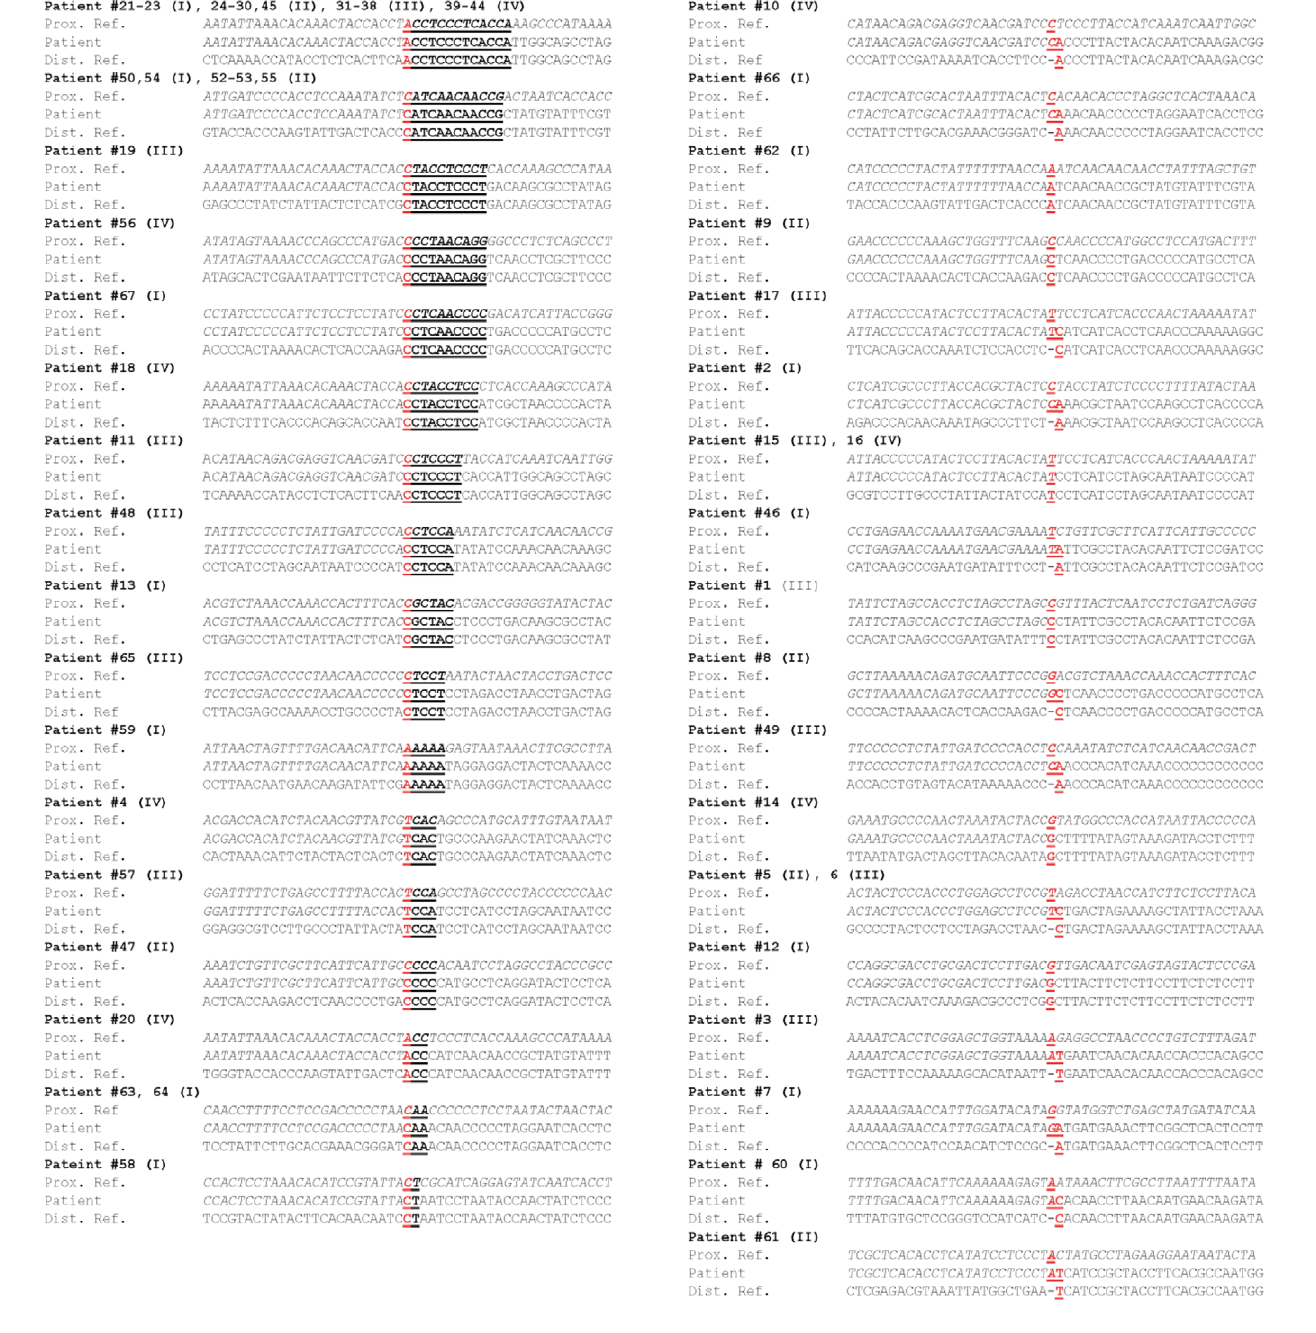
Figure 3. Sequence alignments of mtDNA deletion breakpoints. The two breakpoints in each mtDNA deletion sample (Prox. and Dist. Ref.) were aligned using ClustalW alignment tool. Alignments were grouped based on the location of the breakpoint as either within a direct repeat sequence (type I), or not within a direct repeat sequence (type II). Direct repeats are bolded and underlined. Mapped breakpoint nucleotides are in red. Top strand in each alignment is the proximal breakpoint sequence and bottom is the distal breakpoint sequence from Table S1. Alignments corresponding to the individual patient case from Table S1 are indicated to the left of the alignment.